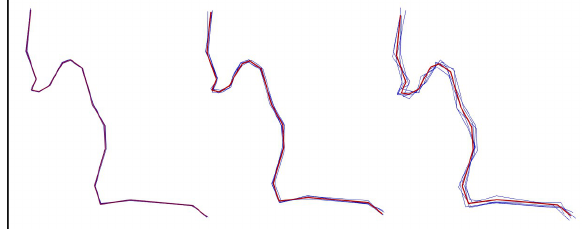
Figure 1. Simulations of digitizing error using different amplitudes of the random